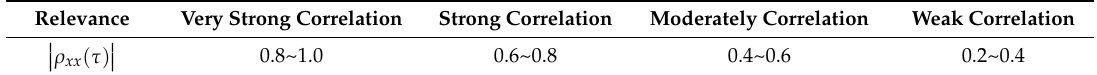
Table 6. Correlation coe ffi cient with its dependence